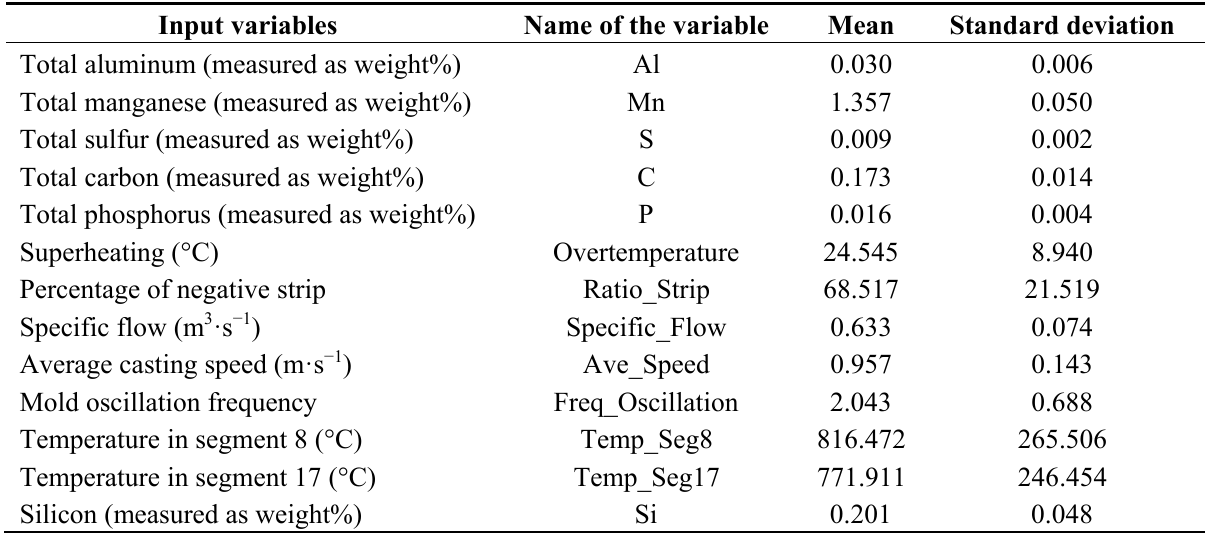
Table 1. Set of input variables used in this study with their mean and standard